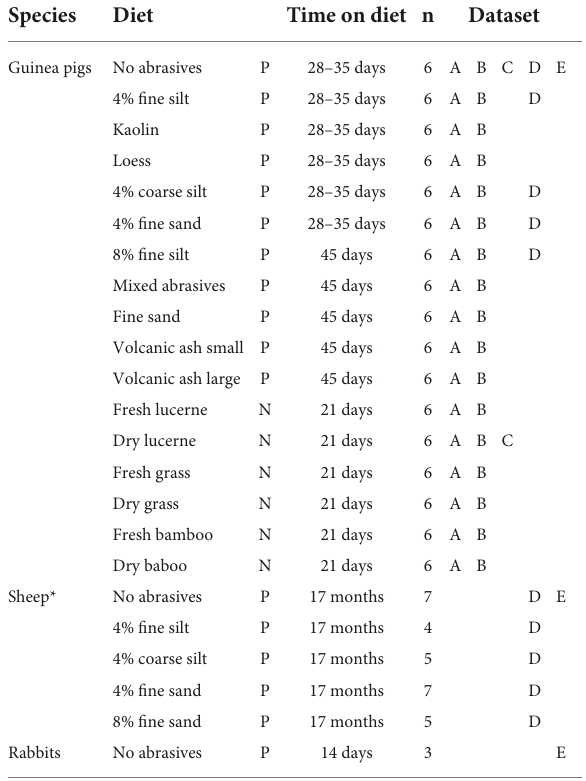
TABLE 1 Overview of diet groups for which DMTA data was included in the correlation analyses. Species Diet Time on diet n Dataset